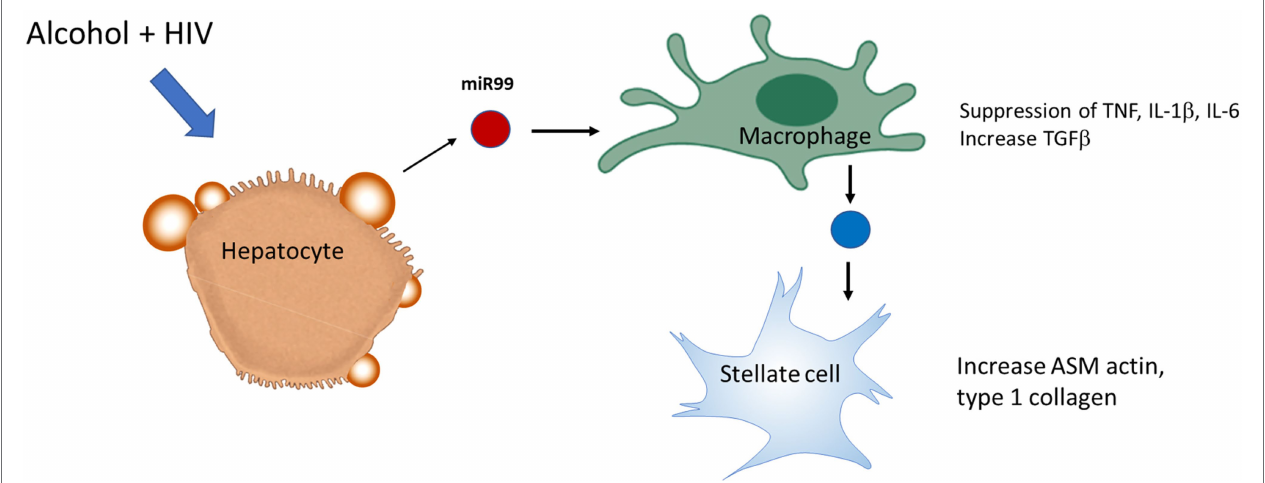
FIGURE 3 | Extracellular vesicles derived from HIV-EtOH exposed hepatocytes (HCs) switch macrophage phenotype from M1 to M2 in HIV-infected macrophages. HCs activated by HIV and ethanol secrete EVs, which contain miRs (as an example, miR99). Engulfment of these exosomes by macrophages switches M1 macrophage phenotype to M2, thereby providing pro-fibrotic activation of hepatic stellate cell